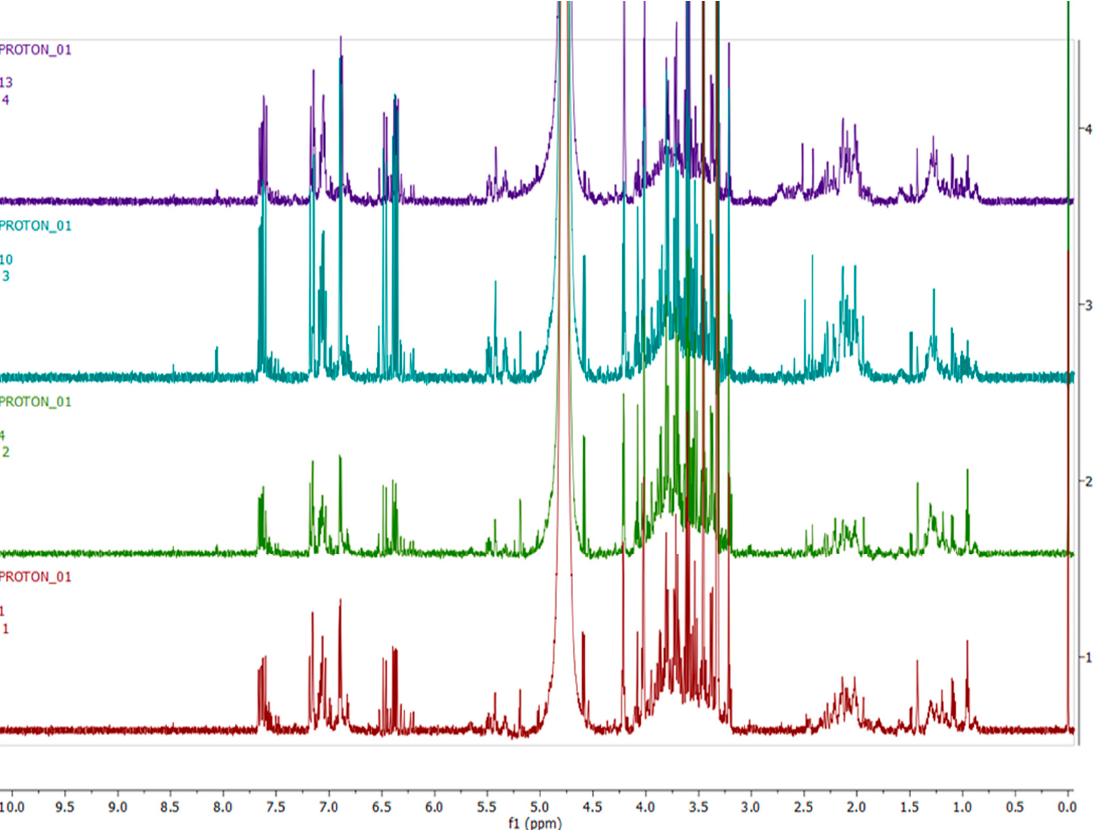
Figure 3. Comparison between samples harvested from wet sites in the spring season across the two locations on the basis of 600 MHz 1 H-NMR spectra of H. aureonitens leaf extracts. Red—spring season, site 1 (wet) Telperion; green—spring season, site 2 (wet) Telperion; light blue—spring season, site 1 (wet) Wakefield; purple—spring season, site 2 (wet) Wakefield.